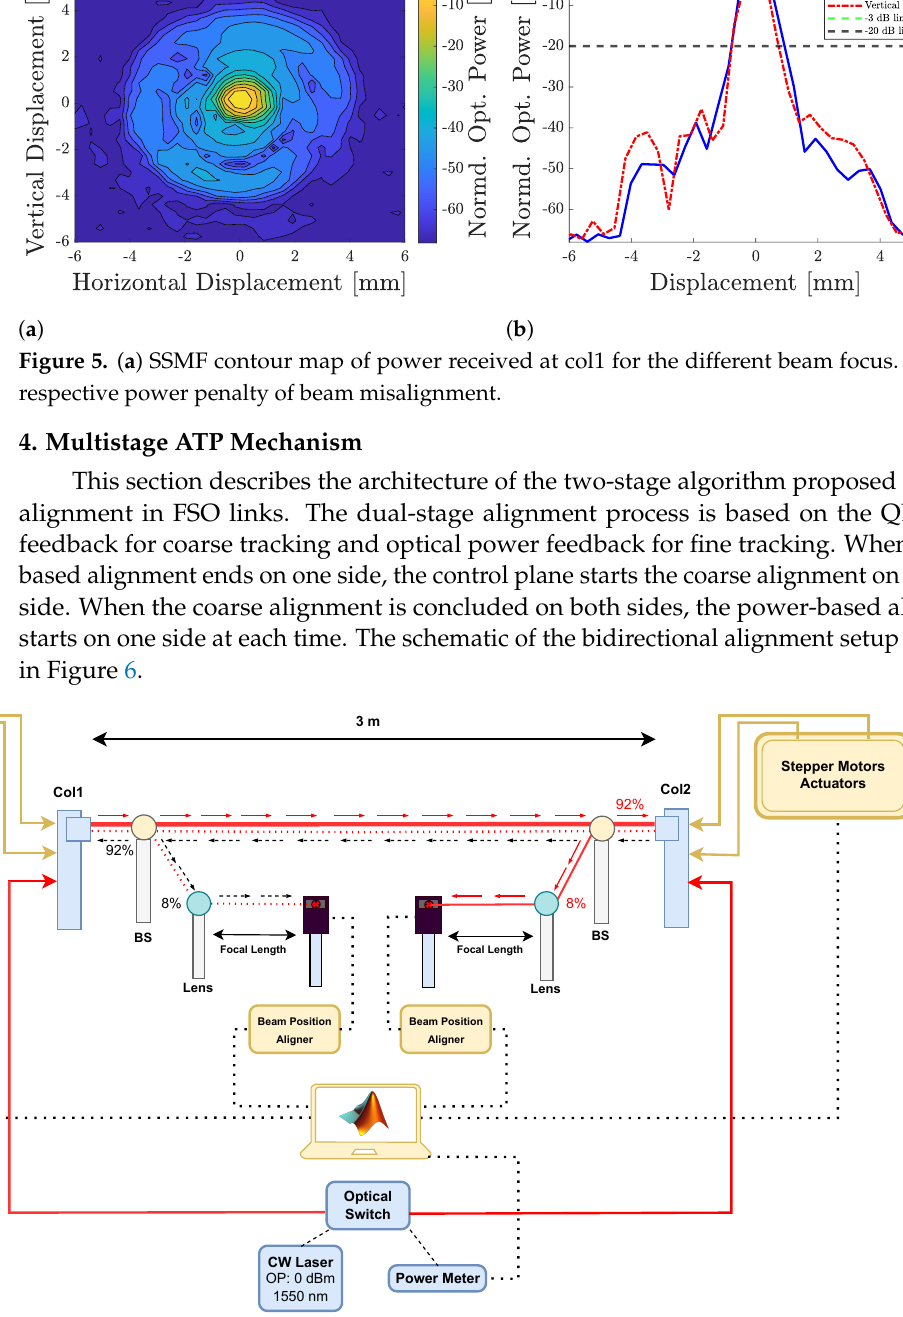
Figure 6. Schematic of the bidirectional ATP mechanism developed. Color codes: blue—optical components; yellow—ATP